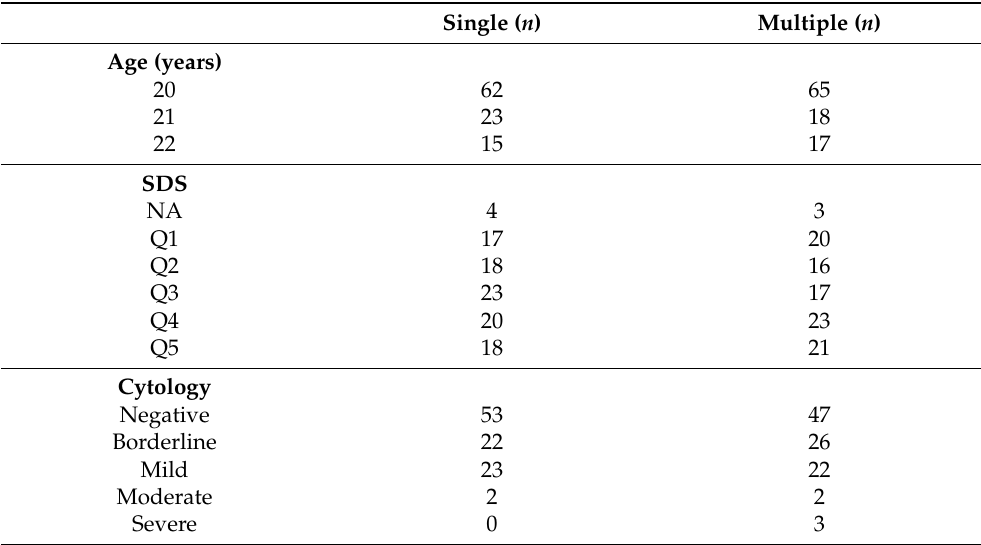
Figure 1. Proportion of single infections in the original cohort study. Table 1. Study population characteristics including by subgroup of single infected HPV51 samples and multiple infections of HPV51 and other HPV